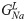
Comparison of resting membrane potential and number of spikes in response to 500 ms stimulus of various strengths in interneurons from NTG and APdE9 mice.Resting membrane potential as a function of GNaL (a) and number of spikes in response to 500 ms of varying stimulus strength for different GNaL values (b) from the model (lines) are compared to the experiment results (symbols). Panels (c) and (d) are the same as (a) and (b) respectively but with varying Gh values. The position of the blue symbol in panels (a) and (c) is adjusted along horizontal axis so that the corresponding GNaL and Gh values reflect these conductances in interneurons from NTG mice.